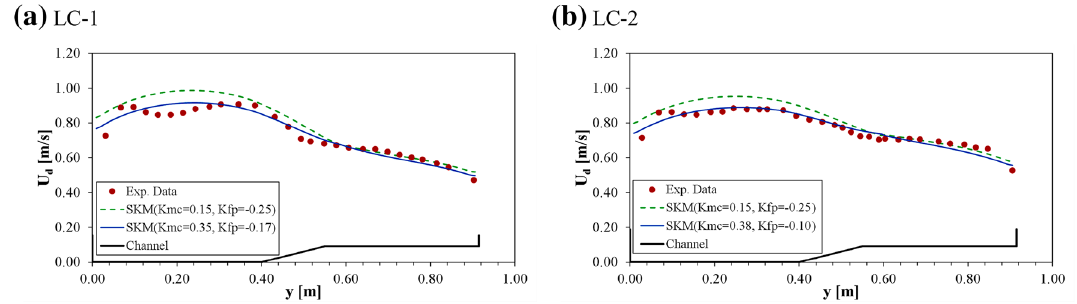
Fig. 3 Results of velocity simulations for large-scale compound channels (the solid line: k calibrated by Devi and Khatua approach, the dashed line: k assumed as Abril and Knight